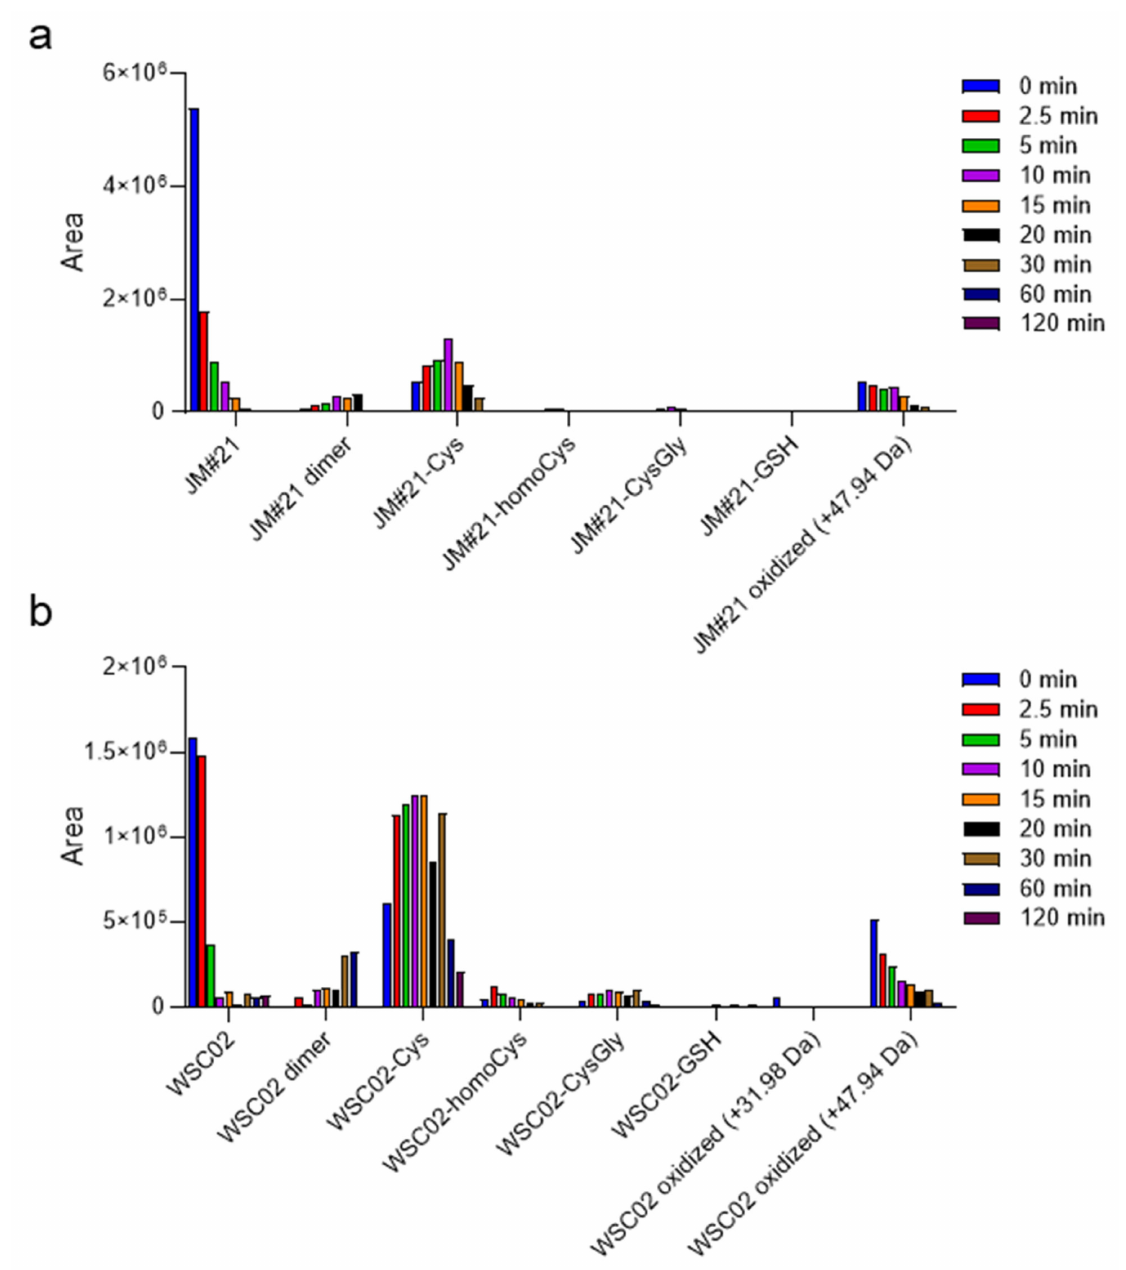
Figure 3. EPI-X4 JM#21 and WSC02 interact with low molecular weight compounds in human plasma via formation of thiol bonds. Aliquots of the mixture of plasma with ( a ) JM#21 or ( b ) WSC02 were taken at t = 0, 2.5, 5, 10, 15, 20, 30, 60, and 120 min and analyzed by mass spectrometry for the presence of disulfide linked cysteine (Cys, +119.0041 Da), homocysteine (homoCys, +133.0198 Da), cysteinylglycine (CysGly, +176.0255 Da), and glutathione (GSH, +305.0682 Da). In addition, their respective dimers and some oxidized (+31.98 Da, +47.94 Da) forms were